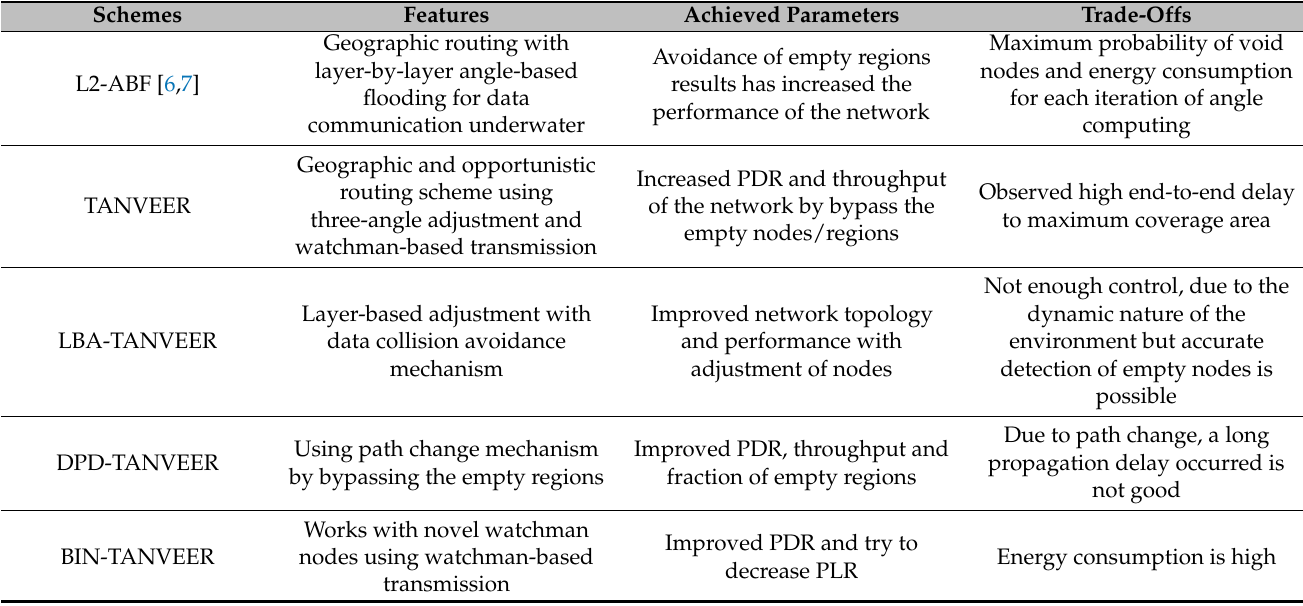
Table 3. Overall performance